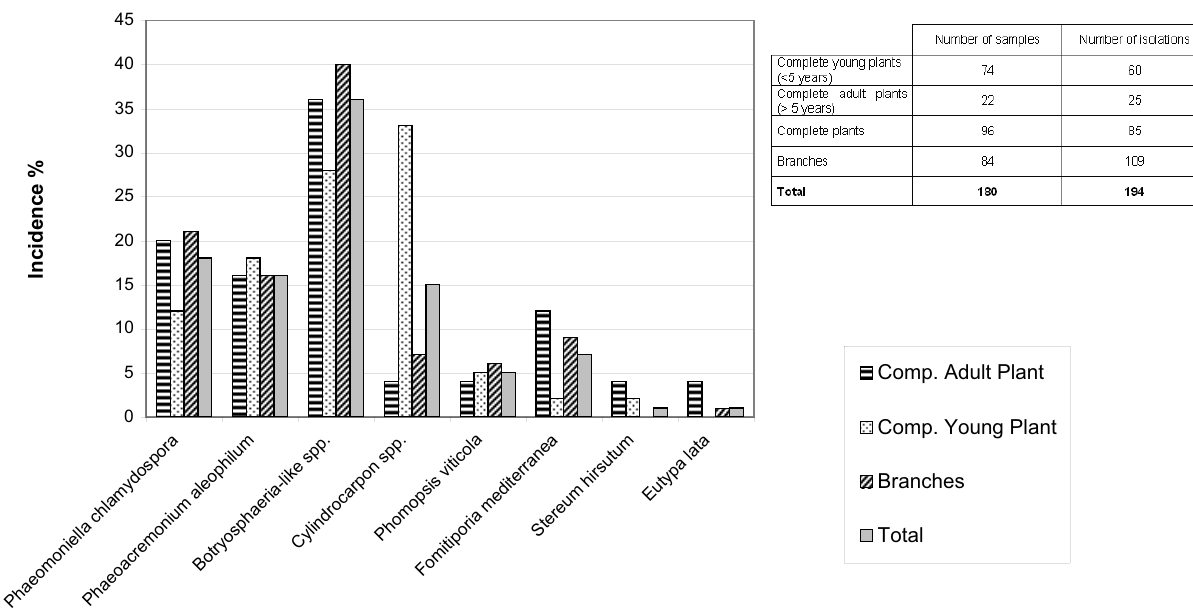
Fig. 1. Incidence of fungi isolated from grapevine. The samples were divided into three categories depending on wether they were taken from: complete adult vines, complete young vines, and adult vine branches. Means of these categories are also given.